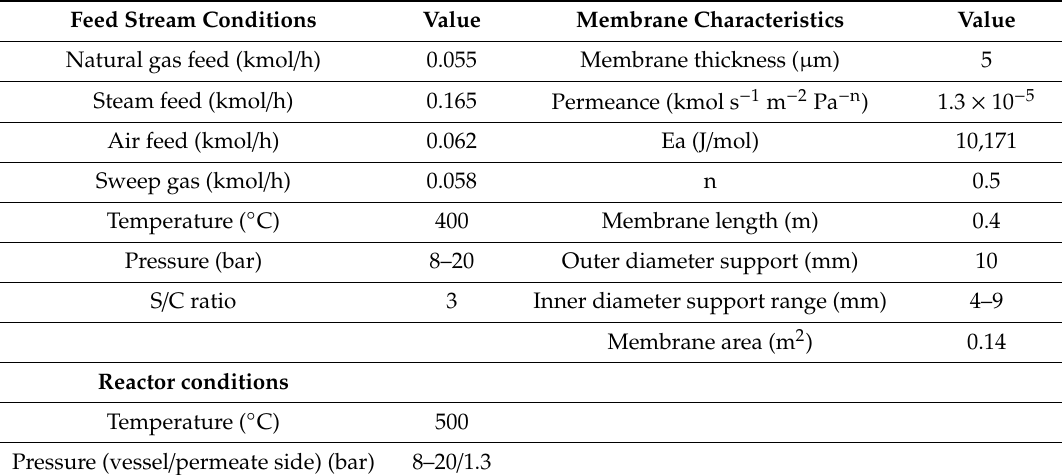
Table 4. Feed stream and reactor conditions, membrane properties [16,27,32].